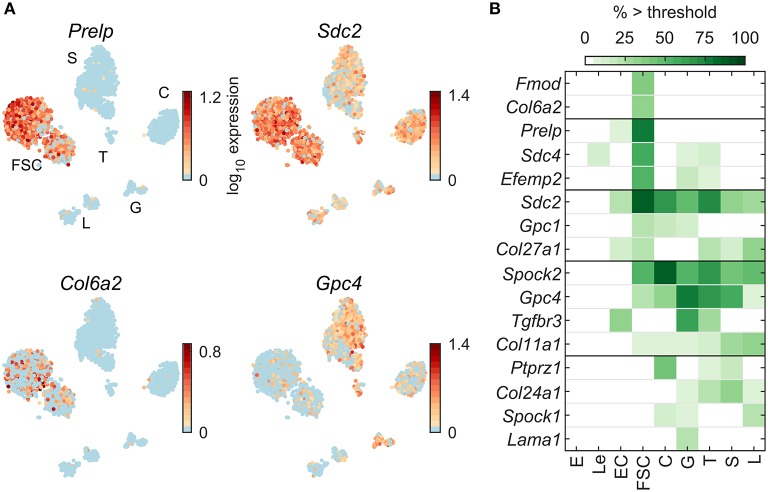
Expression of genes encoding extracellular matrix protein. (A) tSNE map showing expression of select members of extracellular matrix gene families: small leucine-rich proteoglycans (Prelp), syndecans (Sdc2), collagens (Col6a2), and glypicans (Gpc4). (B) Percentage of cells per type expressing select extracellular matrix genes above threshold. From a manually selected list of extracellular matrix genes, including the genes annotated to the Gene Ontology term GO:0005201—Extracellular Matrix Structural Constituent, 53 were expressed in at least 5% of cells in at least one cell type (Table 2) and all 16 pituitary-dominant genes are shown.